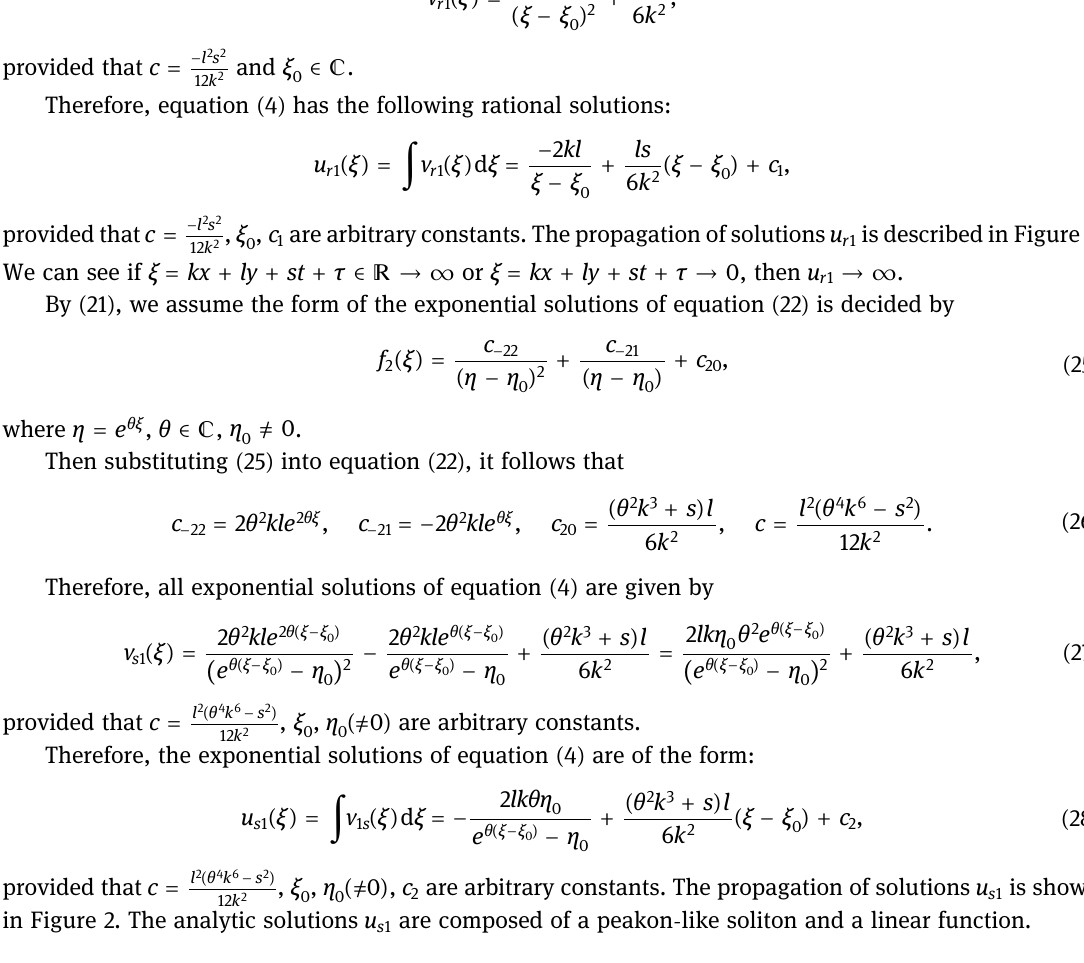
when t −5 = in ( a ) , t 0 = in ( b ) , t 5 = in ( c 0 =